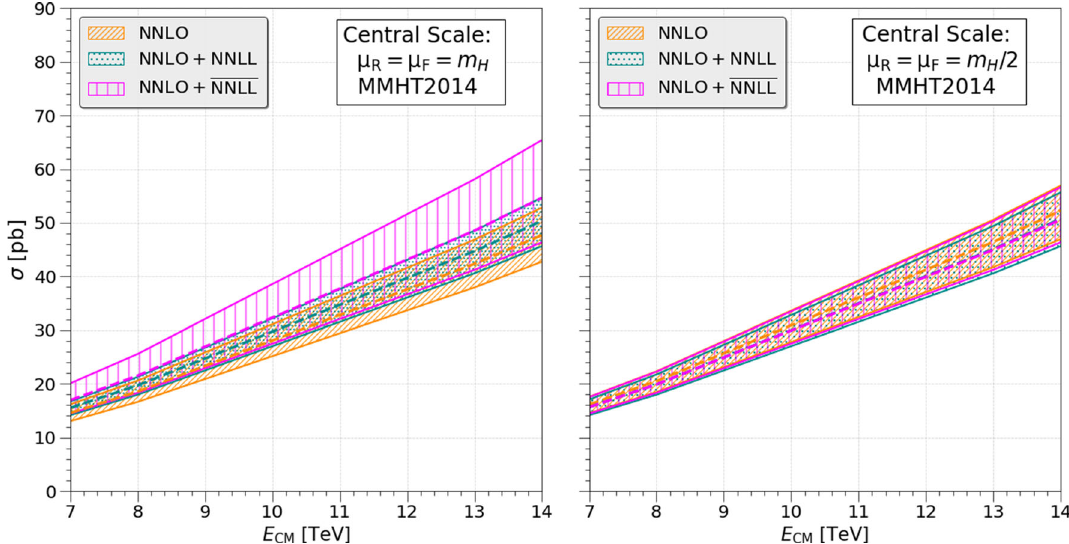
Fig. 6 Fixed order, SV resummed and SV + NSV resummed cross sections plotted against the hadronic centre-of-mass energy(E CM ) at second order in perturbation theory. The band corresponds to the scale